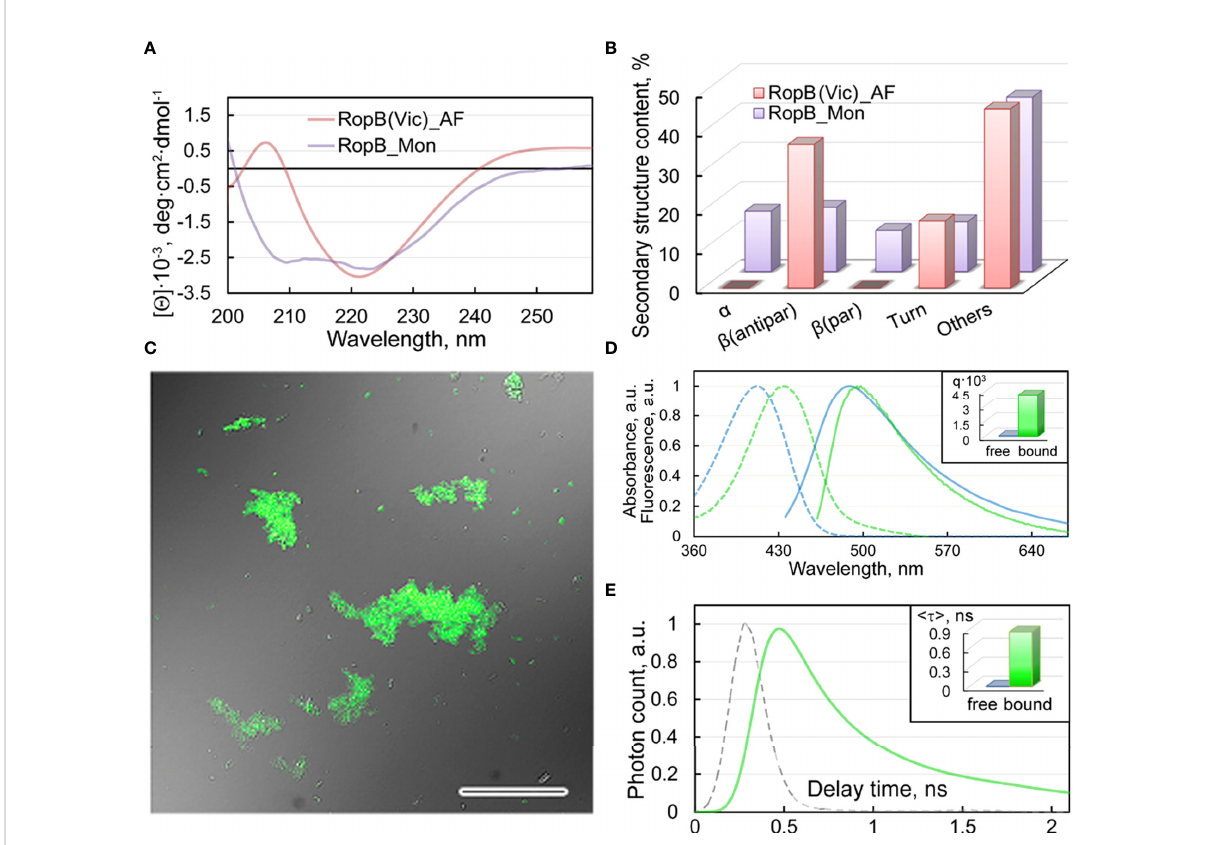
FIGURE 6 Structure and properties of the obtained RopB fi brils (A) CD spectra in the far UV region of RopB in monomeric (purple curve) and fi brillary (pink curve) states. (B) Deconvolution of CD spectra of the RopB in monomeric (purple column) and fi brillary (pink column) state using the BeStSel method (Micsonai et al., 2018). The change in the content of a -helices, parallel and antiparallel b -sheets, b -turns, and other structures (includes 3-10-helices, bends, and unordered structures) are shown. (C) Confocal microscopy of the RopB fi brils stained with ThT. The overlay of the fl uorescence image of the ThT-stained aggregates and the transmitted light image is presented. The scale bar is equal to 50 m m. (D) Normalized to unity at the maximum absorption (dotted curves) and fl uorescence (straight curves) spectra of ThT in free (blue curves) and bound to RopB aggregates (green curves) states. The Inset shows the values of the fl uorescence quantum yield of the dye in free (blue column) and bound to RopB aggregates (green column) states. (E) Fluorescence decay curve of the bound to fi brils ThT (green curve) and excitation laser impulse pro fi le (grey curve). The Inset shows the values of the fl uorescence lifetime of the dye (in nanoseconds - ns) in free (blue column) and bound to RopB aggregates (green column)